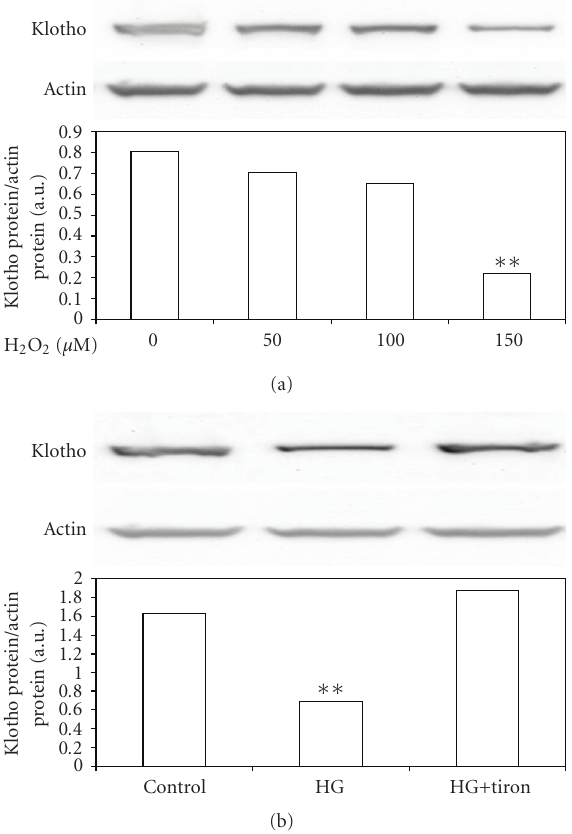
Figure 5: Changes in Klotho expression levels in cultured MDCK cells. (a) Western blot analysis of Klotho expression in normal glucose (5mmol/L) medium in MDCK cells treated with H 2 O 2 . Upper picture shows the protein level of Klotho or actin in MDCK cells. ∗∗ P < . 001 compared to MDCK cells without H 2 O 2 treatment. Western blot analysis was used to detect Klotho (b) expression in MDCK cells cultured with normal glucose (5mmol/L; control) or high glucose (40mmol/L glucose; HG) medium with or without tiron (10mmol/L) treatment. Upper picture shows the protein level of Klotho or actin in MDCK cells. Quantification of protein levels indicated as means with SE ( n = 4 per group) in each column are presented in the lower panel. ∗∗ P < . 001 compared to